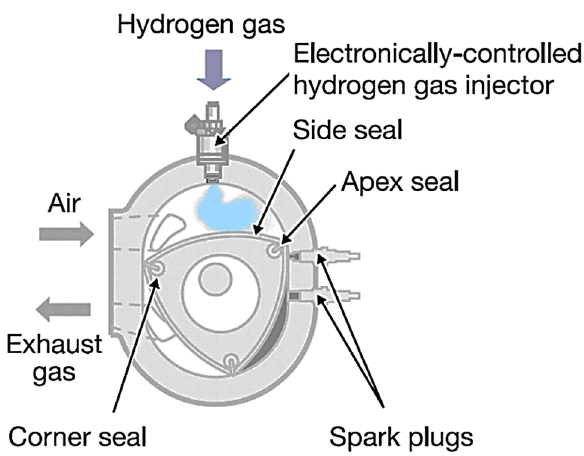
Figure 1. Diagram of the hydrogen-fueled RE (Ozcanli et al. [7]).